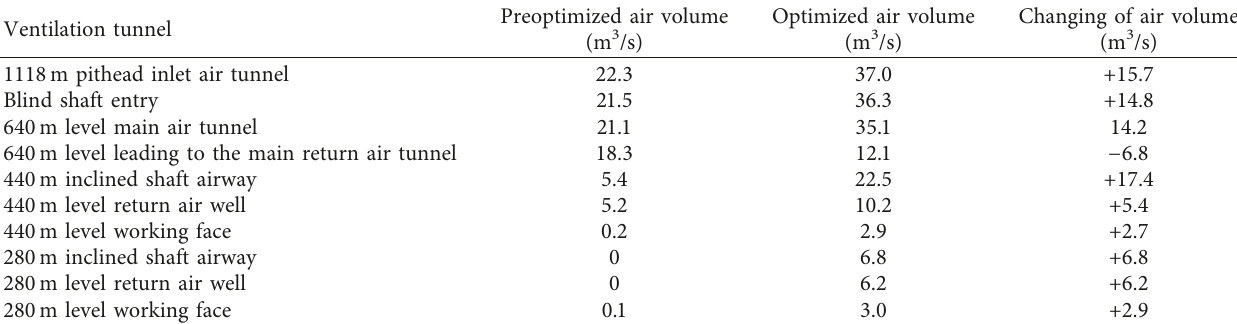
Table 2: The measured air volume of main roadway before and after transformation of ventilation system. Ventilation tunnel